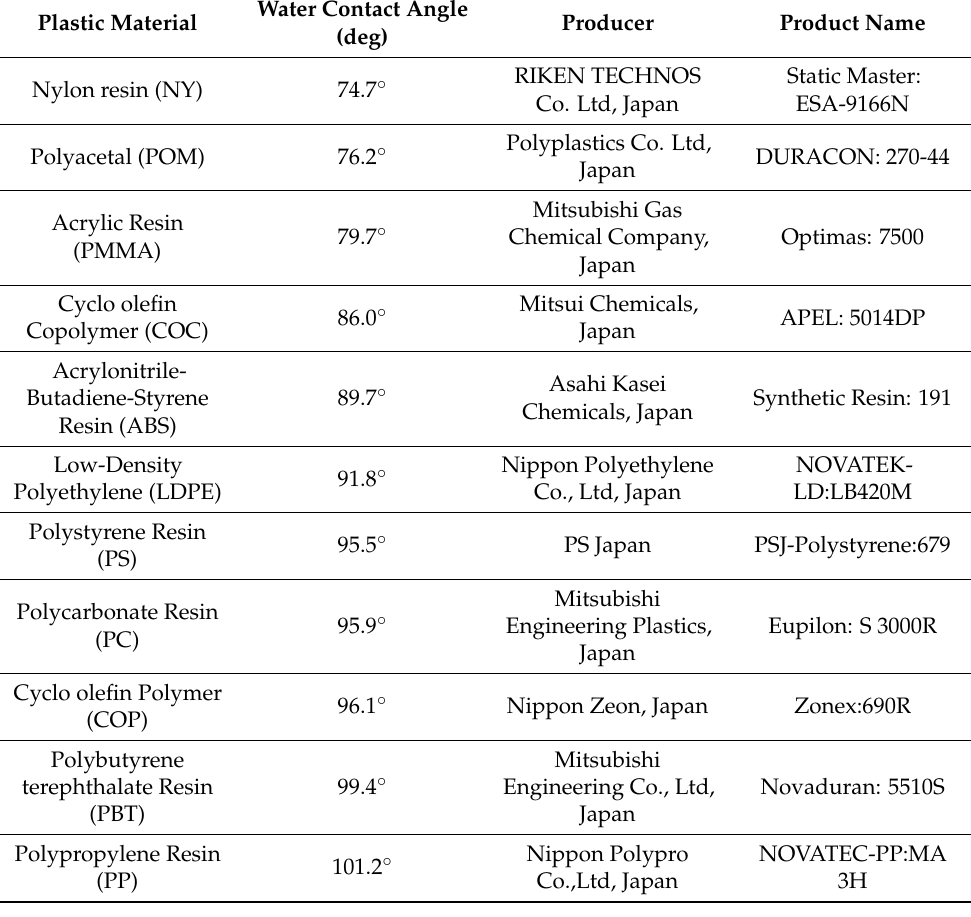
Table 1. Water contact angle for several types of plastic materials.